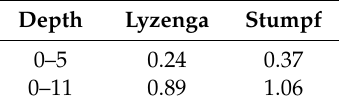
Table 4. The Root Mean Squared Error (RMSE) (m) of di ff erent depth ranges for UDB with Lyzenga and Stumpf